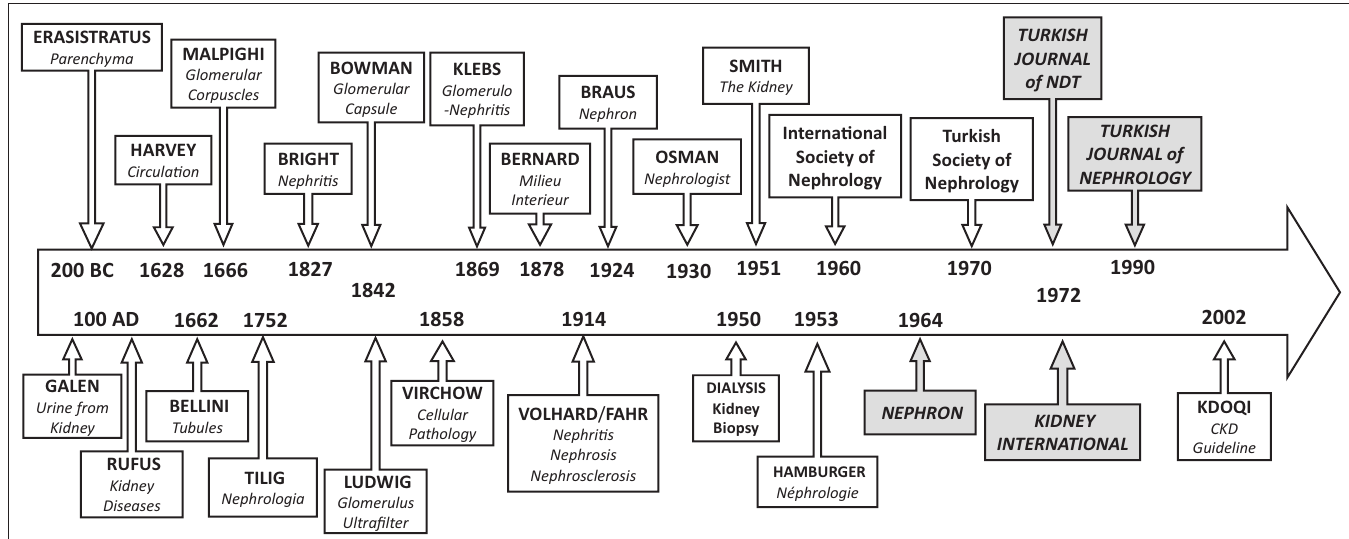
Figure 1. Timeline of the evolution of nephrology as a discipline. The name of the principal contributors is shown in bold capital letter and their contribution in smaller italic letter. Boxes highlighted in grey refer to institutions and journals. CKD, chronic kidney disease; KDOQI, Kidney Disease Outcomes Quality Initiative; NDT, nephrology, dialysis,